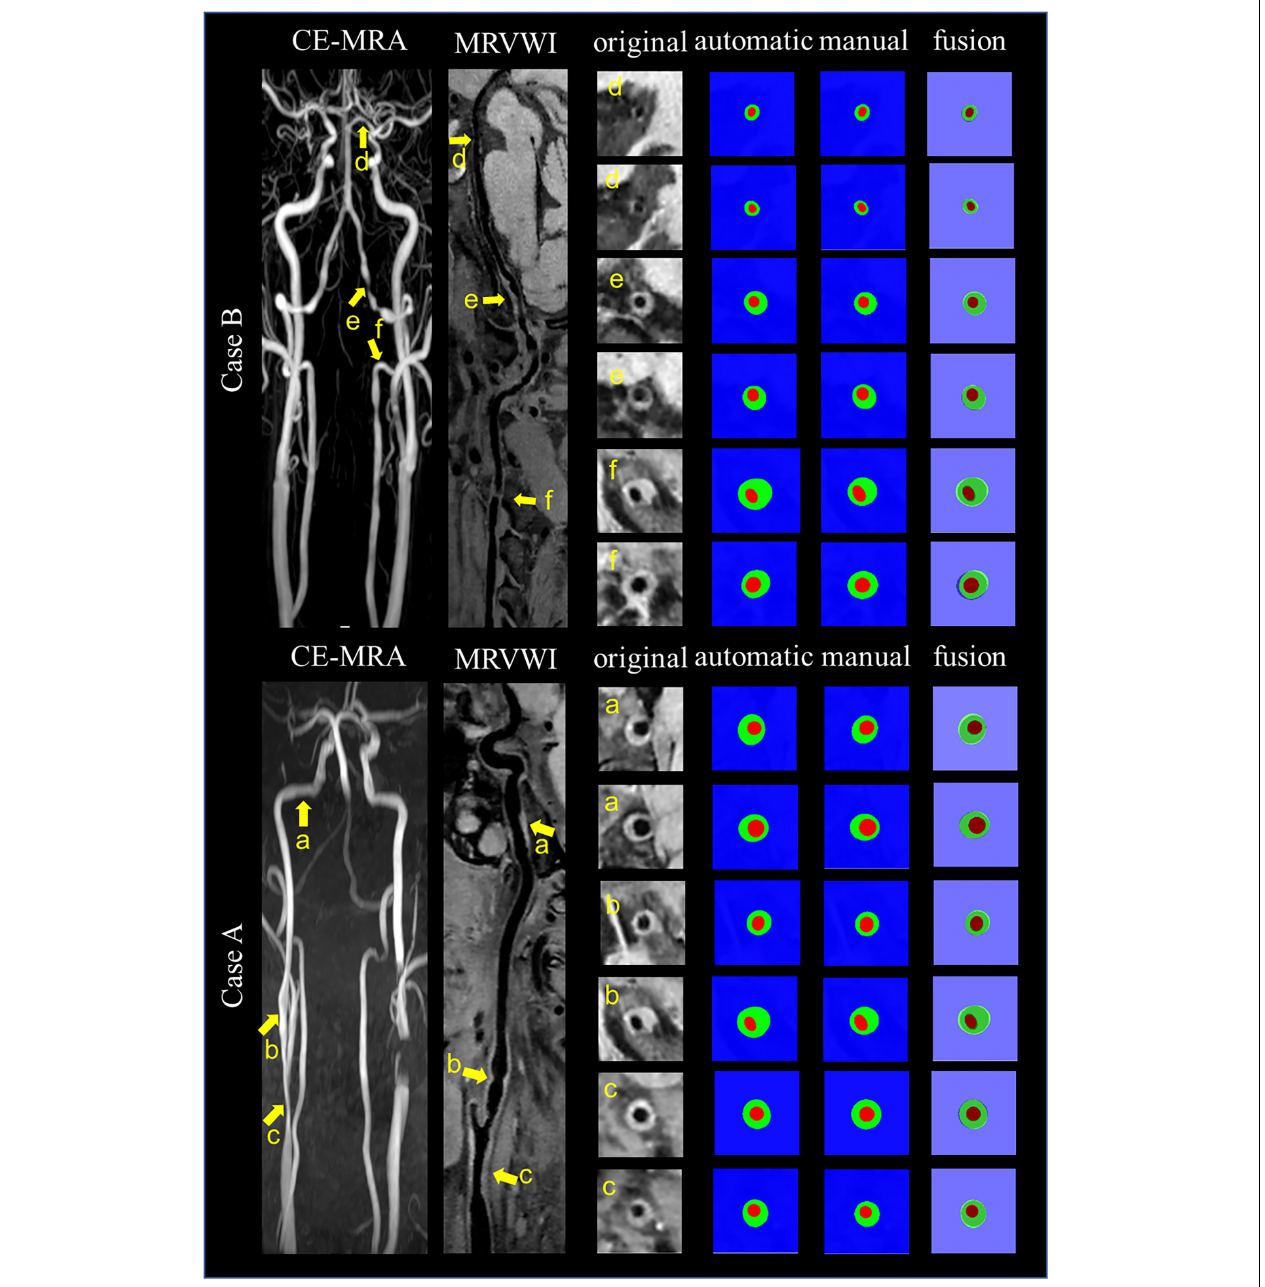
FIGURE 6 | Representative images and segmentation results from two clinical cases. Case A and Case B represent the images with anterior circulation and posterior circulation, respectively. Case A shows three stenoses at the right CCA to ICA (arrows a, b, and c on the CE-MRA image), corresponding plaques (arrows a, b, and c on the MR vessel wall image), original cross-sectional slices reconstructed from the plaques (a–c), the automatic and manual segmentation results for the plaques, and the segmentation results of fusion from left to right. Case B shows three stenoses at the left VA to PCA (arrows d, e, and f on CE-MRA image), corresponding plaques (arrows d, e, and f on MR vessel wall image), original cross-sectional slices reconstructed from the plaques (d–f), the automatic and manual segmentation results for the plaques, and the segmentation results of fusion from left to right.